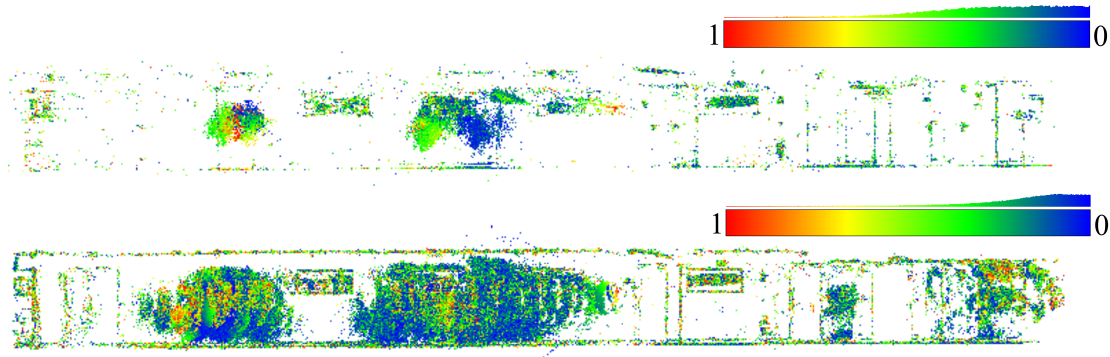
Figure 23. Tie-points in 3D space with its re-projection error coded in color. The color scale bar presents a histogram of re-projection error in range [0,1] pixel. ( Top ): classical processing with SIFT, ( Bottom ): by SIROP . The holes in the model caused by very low dynamic image in these scene parts.